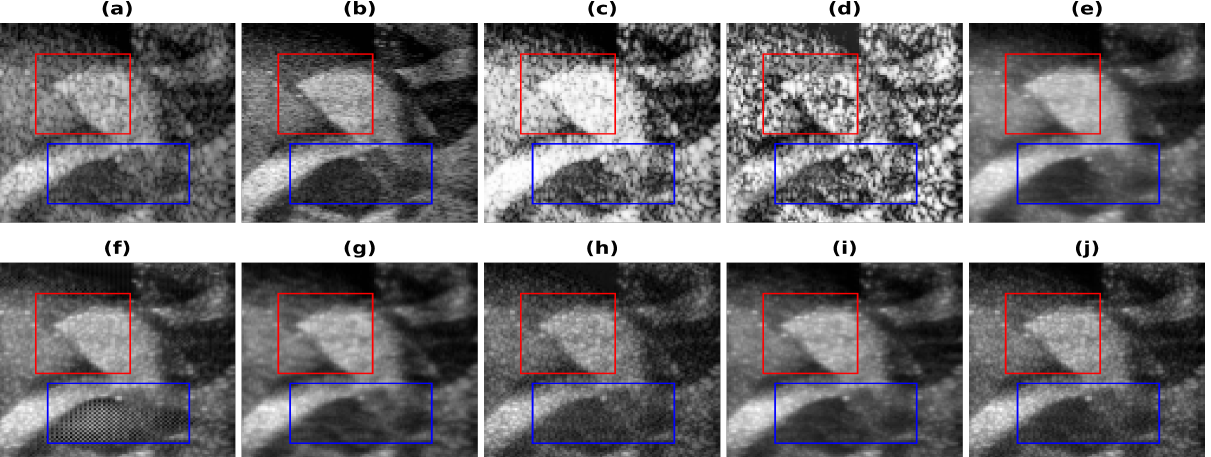
Figure 4. Results of the bandwidth improvement for Phantom I for different models ( a ) Band- limited image ( b ) Full Bandwidth image ( c ) Histogram Equalization ( d ) Contrast Limited Adaptive Histogram Equalization ( e ) U-Net-PL1 ( f ) U-Net-PL2 ( g ) SRCNN-PL1 ( h ) SRCNN-PL2 ( i ) REDNet- PL1 ( j ) REDNet-PL2. Red and blue boxes show the different marked